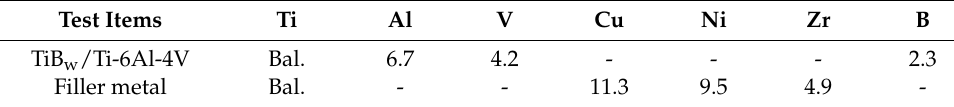
Figure 1. ( a ) Microstructure of TiB w /Ti-6Al-4V composite; ( b ) time–temperature heating curve at brazing process; ( c ) image of tensile-test samples, and ( d ) brazing sample. Table 1. Chemical composition of TiBw/Ti-6Al-4V composite and filler metal